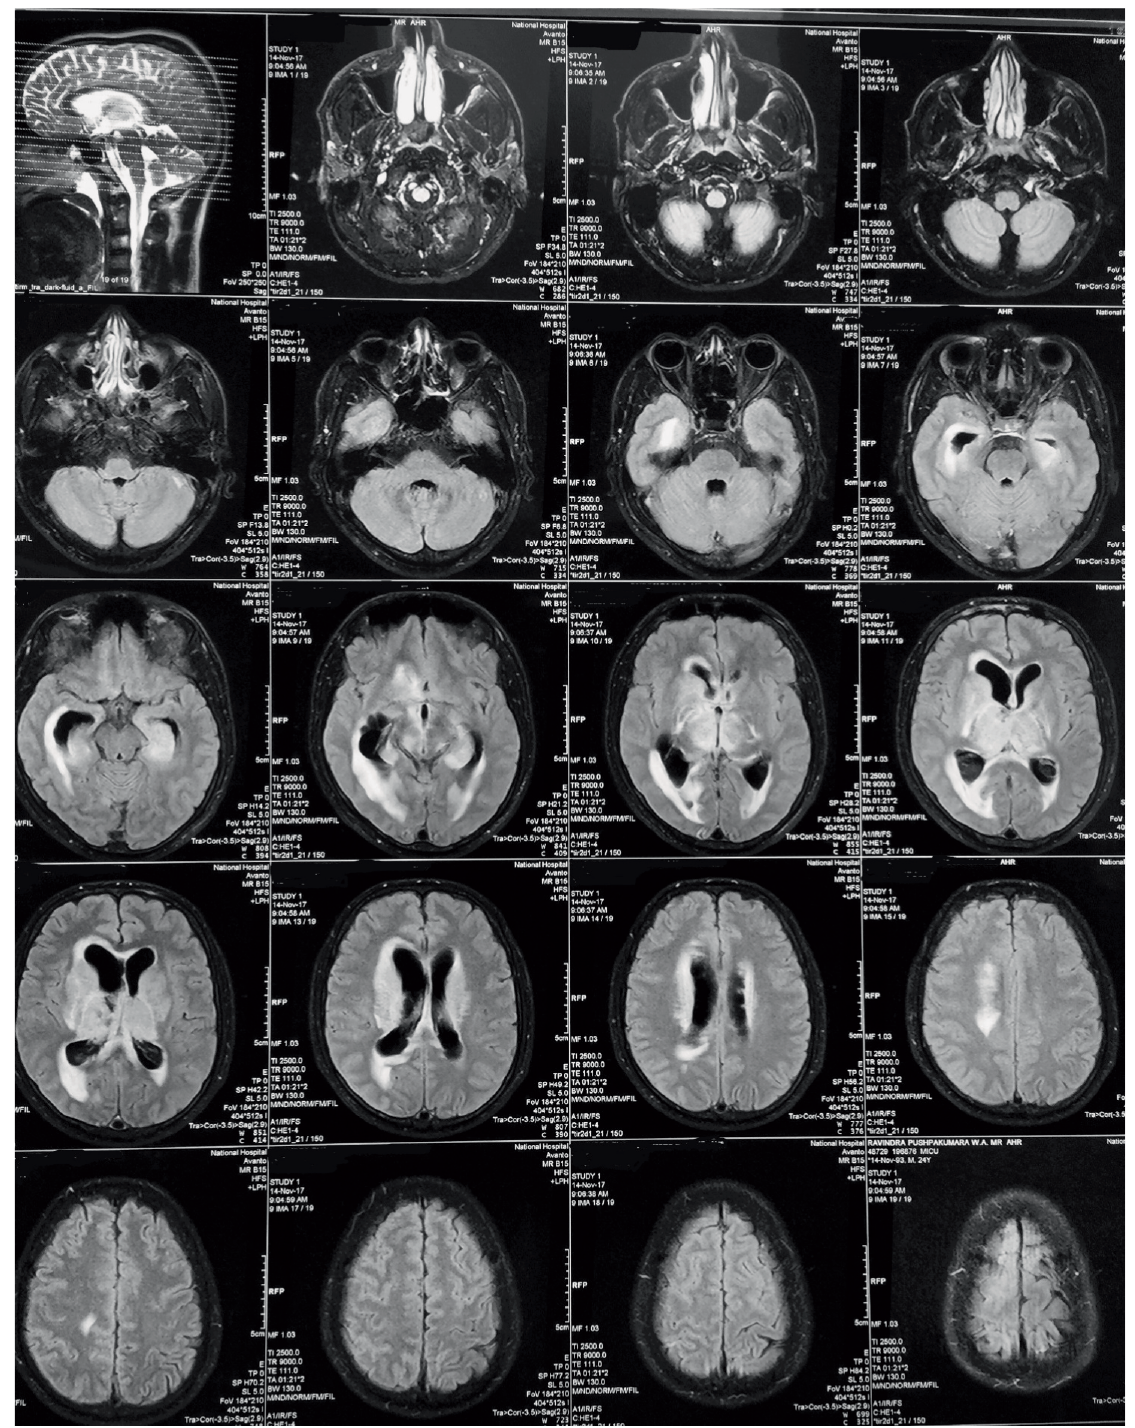
Figure 1: MRI showing hydrocephalus, periventricular oedema and